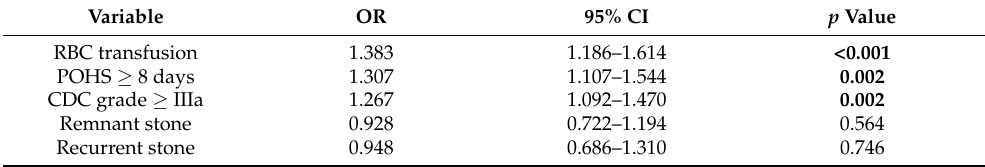
Figure 2. Scatter plots for nDSS versus operation time ( A ) and EBL ( B ). The vertical line splits the patients into two groups, low and high groups, and the oblique lines represent the correlations between the variables. nDSS modified difficulty scoring system. Table 4. Surgical outcomes based on the novel difficulty scoring system.